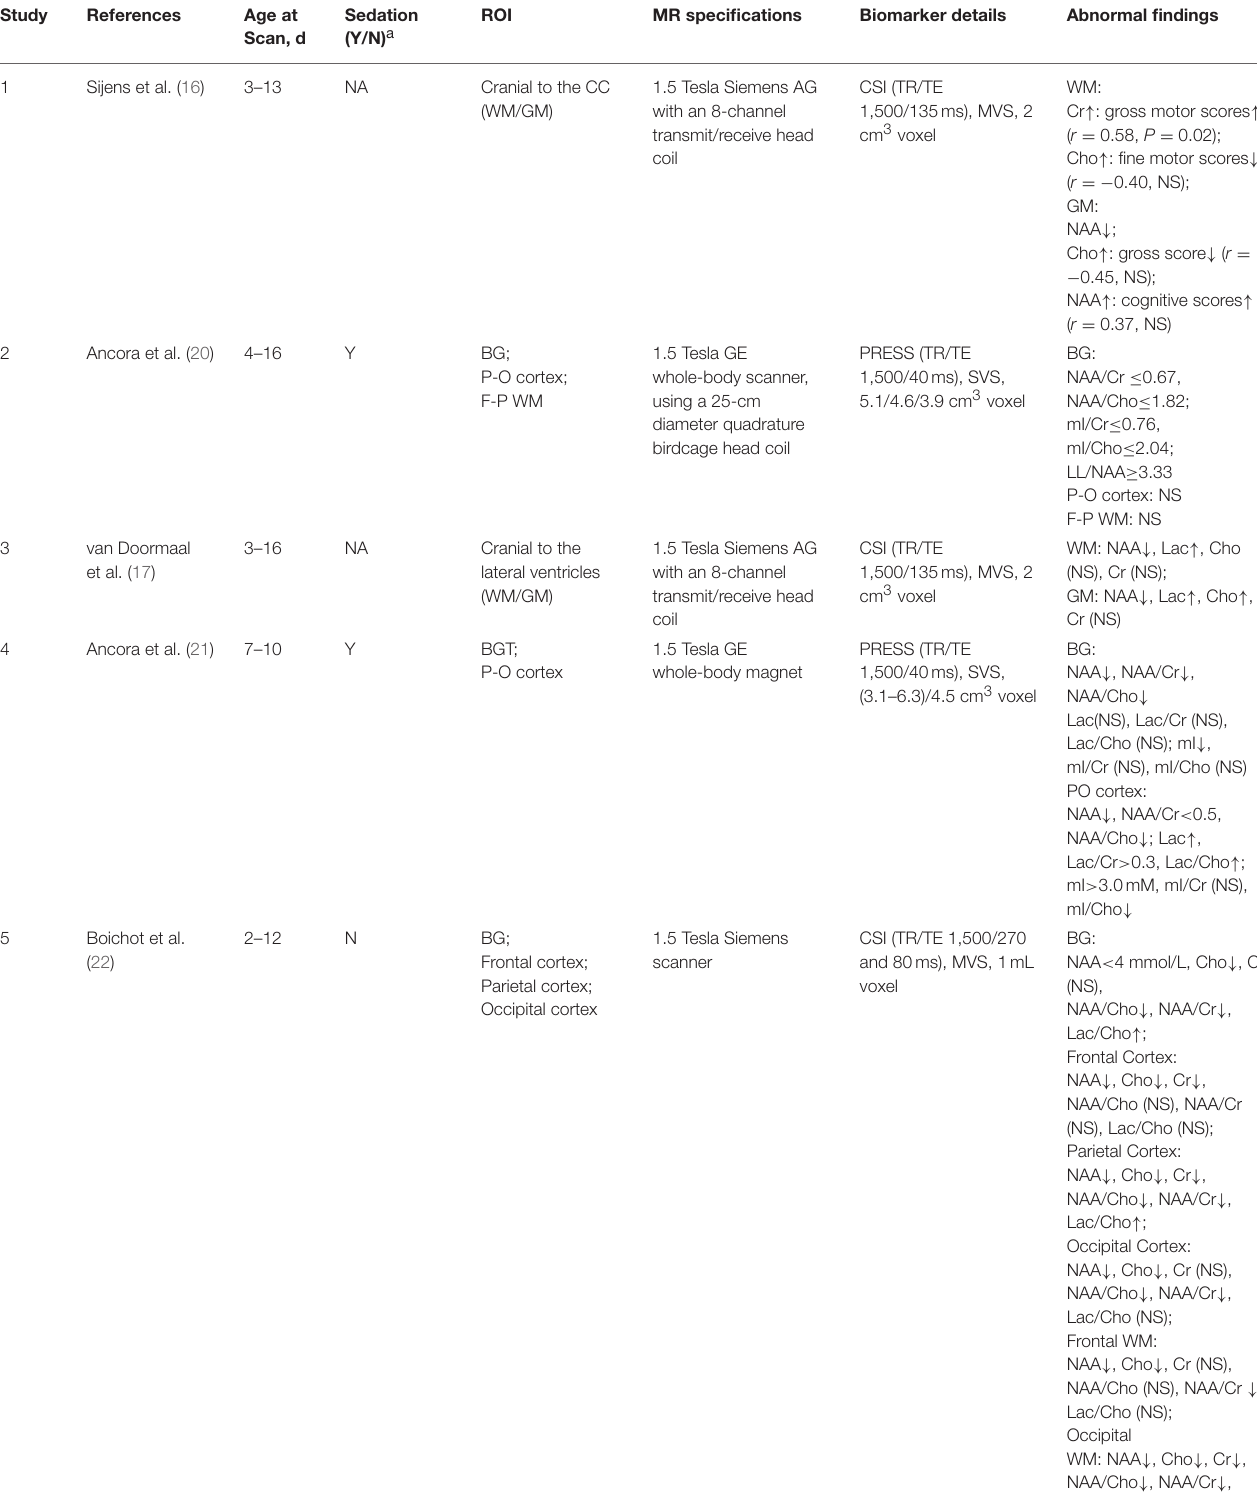
TABLE 3 | Details of proton magnetic resonance spectroscopy